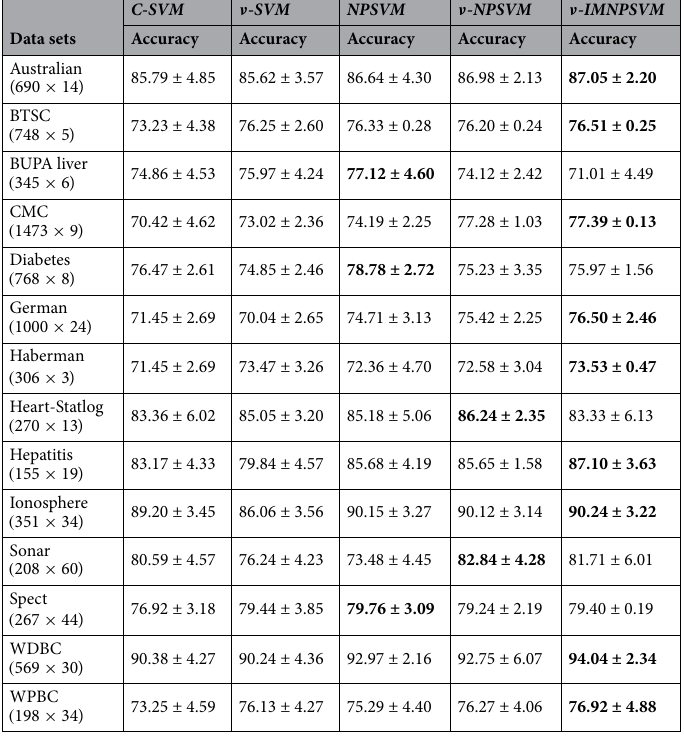
Table 1. Tenfold testing percentage accuracy of linear classifiers. Significant values are in